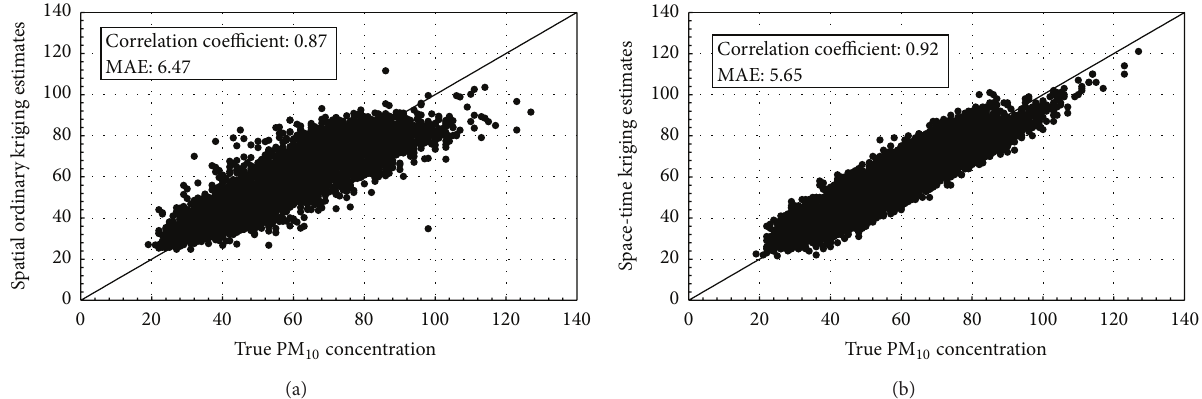
Figure 9: Scatter-plots with error statistics from leave-one-out cross validation: (a) spatial ordinary kriging and (b) space-time kriging.